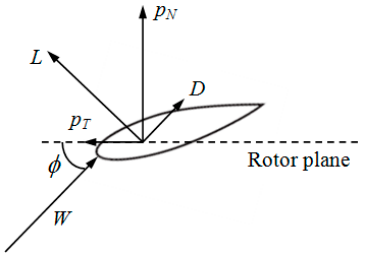
Figure 4. The local loads on a blade cross section.